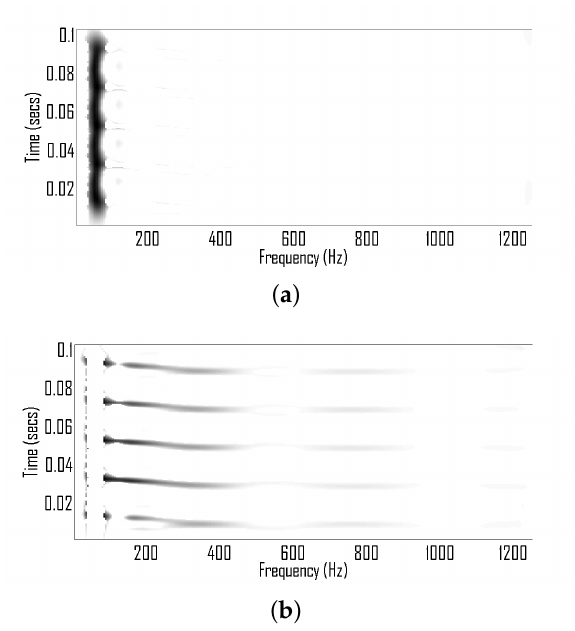
Figure 8. Separation of TF representation of tones and spikes using the direction of signal energy ( a ) TF representation of tones; and ( b ) TF representation of